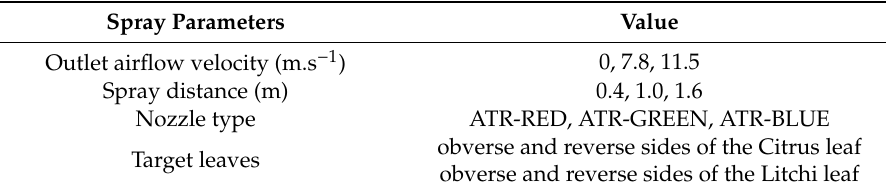
Table 6. Spray parameters of the trial.